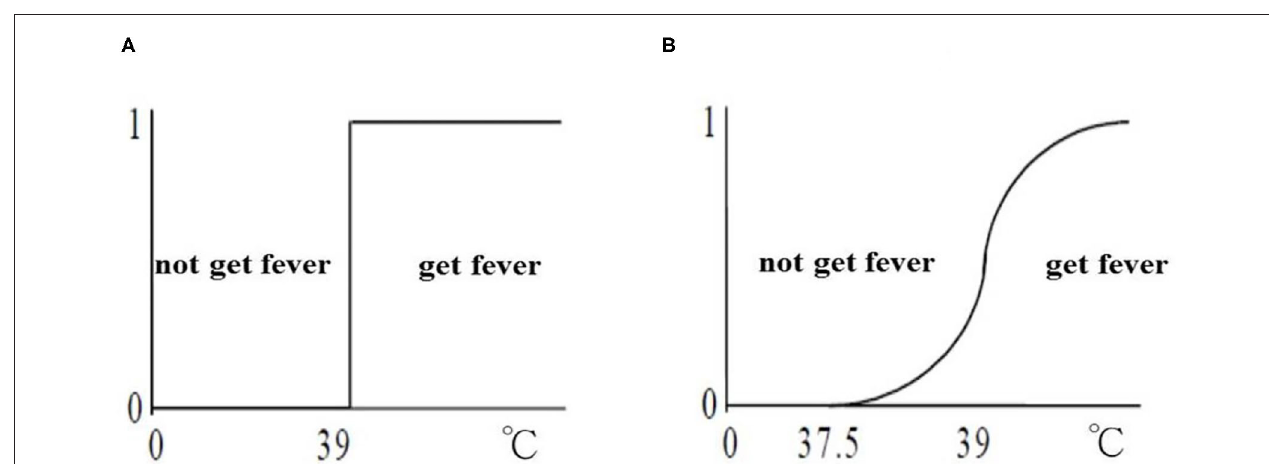
FIGURE 2 | (A) Classical set and (B) fuzzy set.